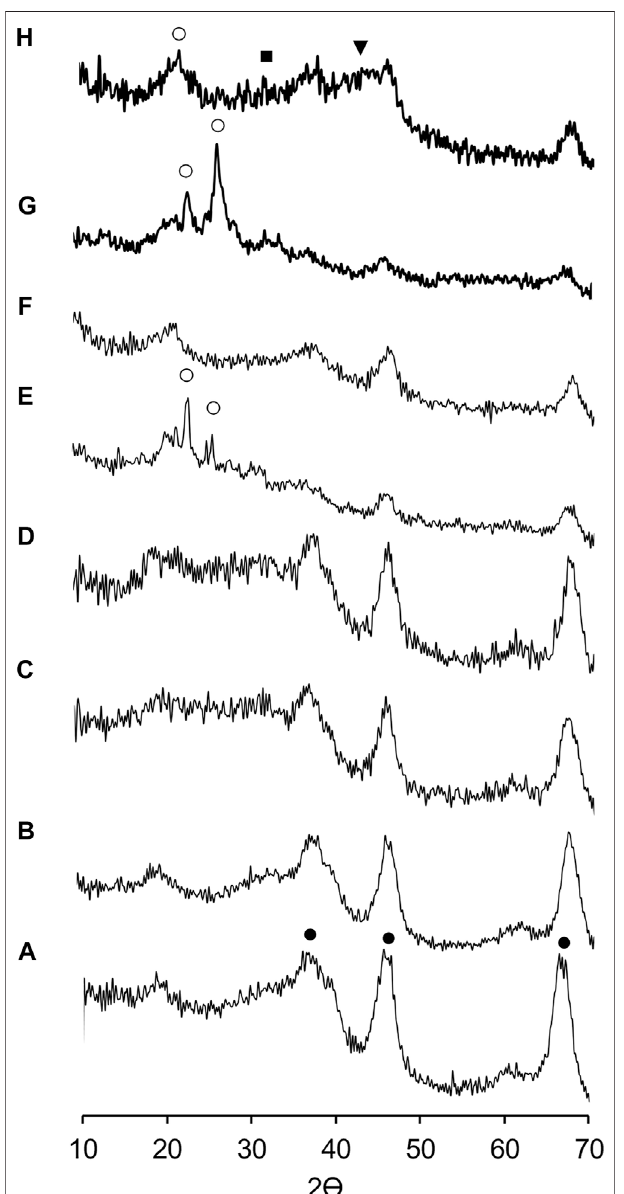
FIGURE 1 | X-ray diffraction patterns of supports and the Al 2 O 3 -MgO supported NiMo mixed phosphidic-sulphidic phase: (A) Al 2 O 3 , (B) Al 2 O 3 - MgO, (C) NiP-O/ γ -Al 2 O 3 -MgO, (D) NiP-S/ γ -Al 2 O 3 -MgO, (E) MoP-O/ γ -Al 2 O 3 - MgO, (F) MoP-S/ γ -Al 2 O 3 -MgO, (G) NiMoP-O/ γ -Al 2 O 3 -MgO, and (H) (cid:129) NiMoP-S/ γ -Al 2 O 3 -MgO. ( ) γ -Al 2 O 3 , ( ■ ) MoP, ( ▼ ) NiMoP, and ( ○ ) (cid:129) (NH 4 ) 3 PO 4 (MoO 3 ) 12 4H 2 O.